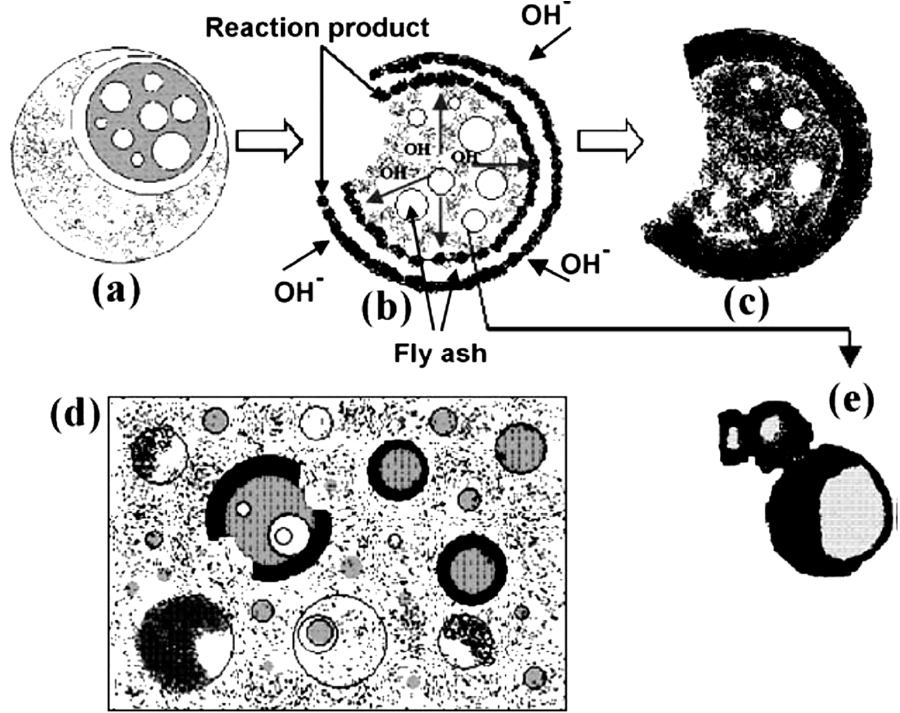
Figure 20. A descriptive model of FA activation by alkali: ( a ) initial chemical attack, ( b ) bi-directional alkaline attack, ( c ) reaction product, ( d ) gel, ( e ) unreacted particles. Adapted from [247].